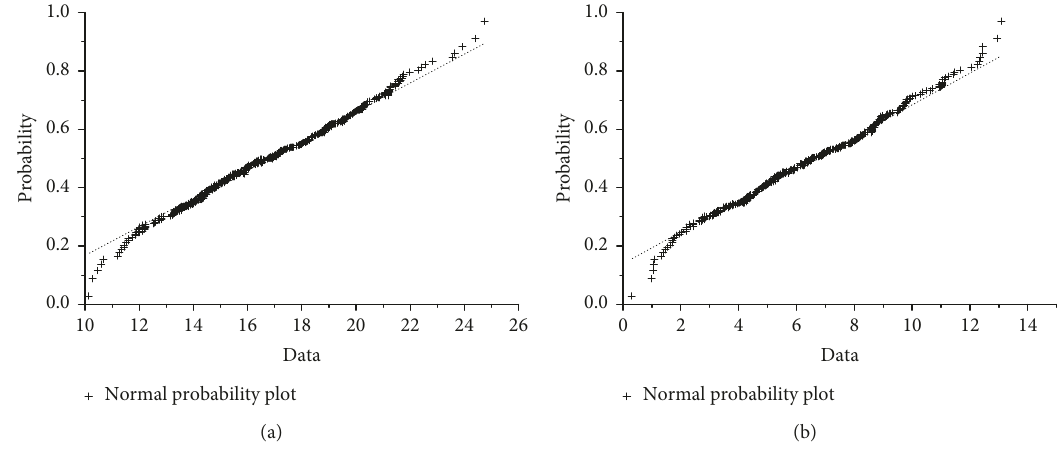
Normal probability Figure 6: The distribution probability diagram of the daily extreme value of axial uniform temperature in February. (a) The maximum. (b) The